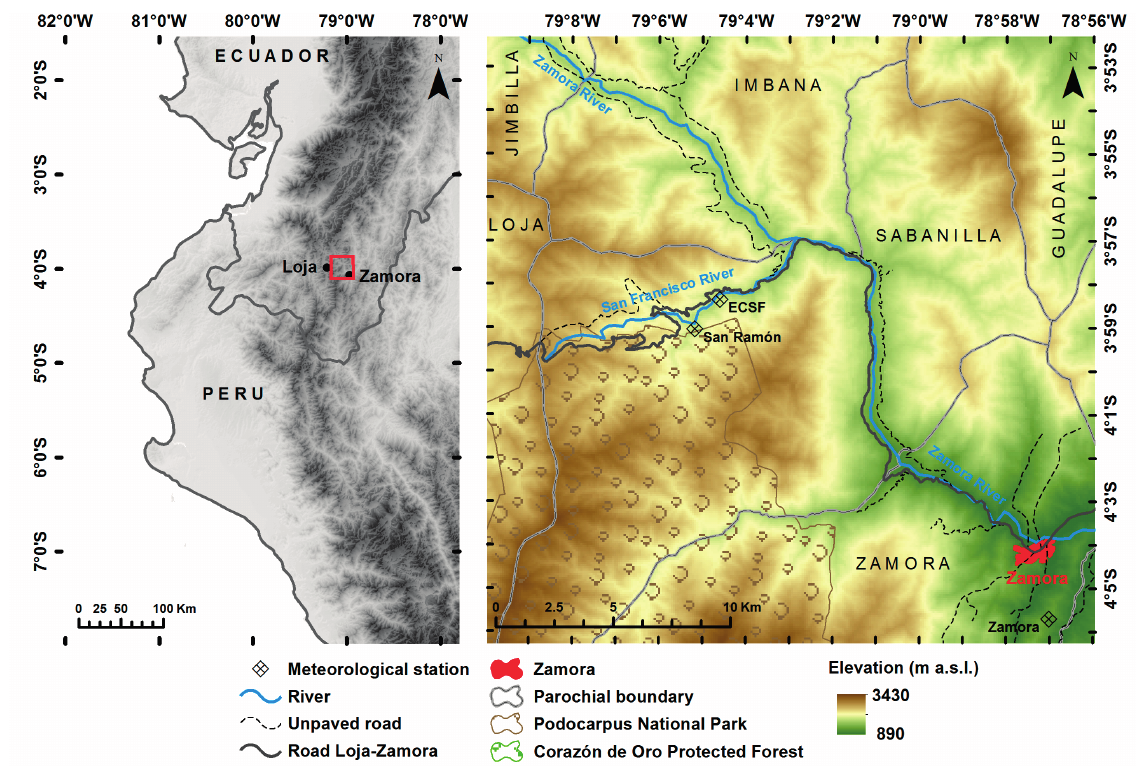
Figure 1. Study area embedded in the Andes of southern Ecuador ( left ) with a detailed view corresponding to the extension of the analyzed satellite data ( right